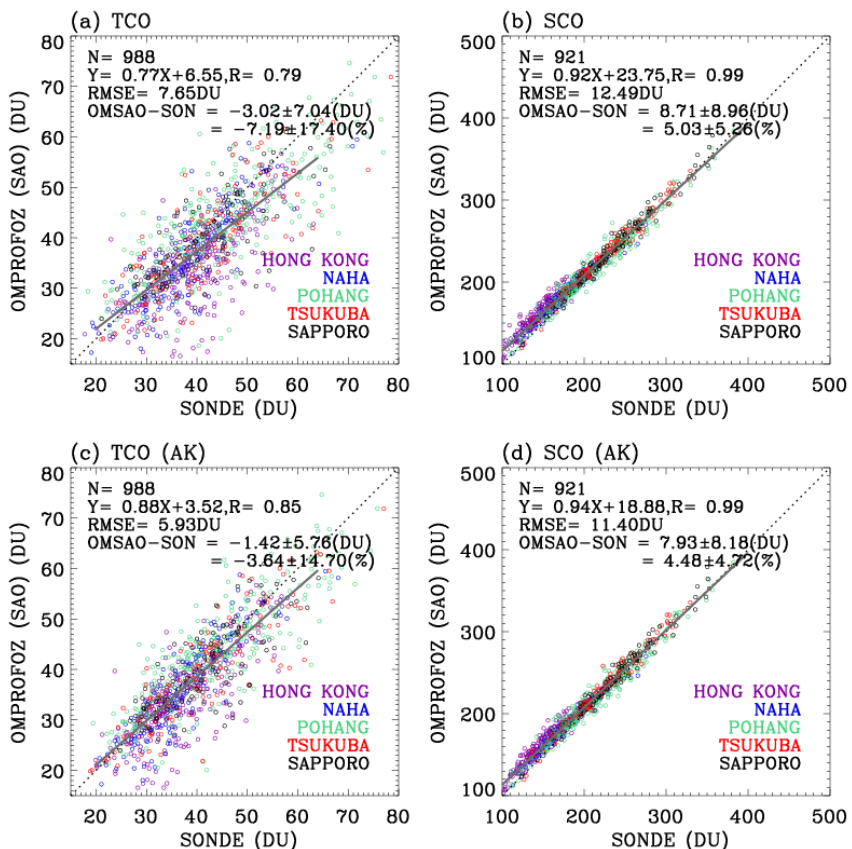
Figure 10. Same as Fig. 8 but for validating OMI research ozone profiles (OMPROFOZ) produced by the SAO OE-based